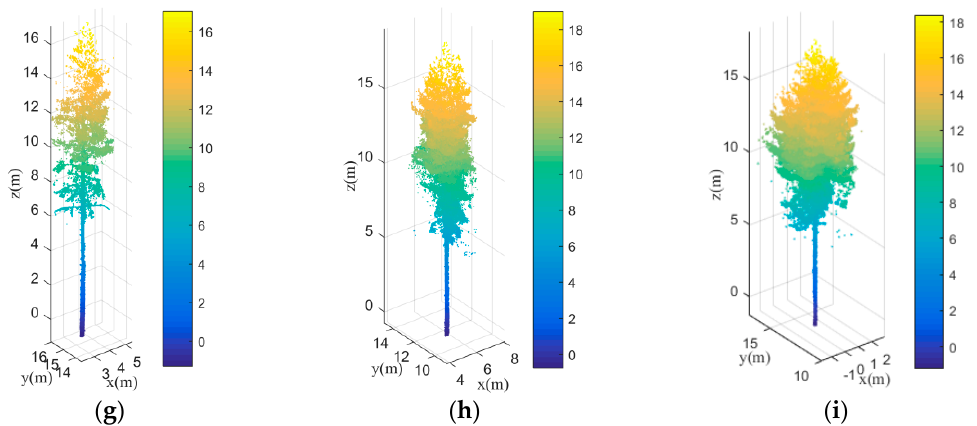
Figure 13. Nine instances of extracted individual tree. ( a – i ) are the extracted individual trees. From Figure 13, it can be found that the individual trees can be extracted correctly.